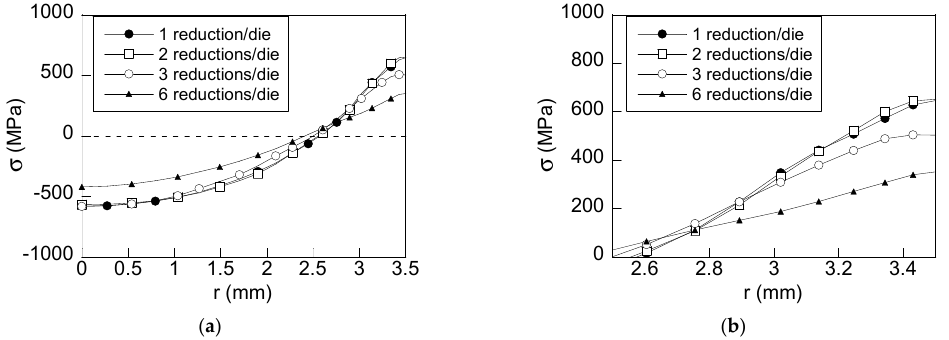
Figure 5. Radial distribution of hydrostatic stress: ( a ) general view; ( b ) detailed view of the important near-surface region of the wire.